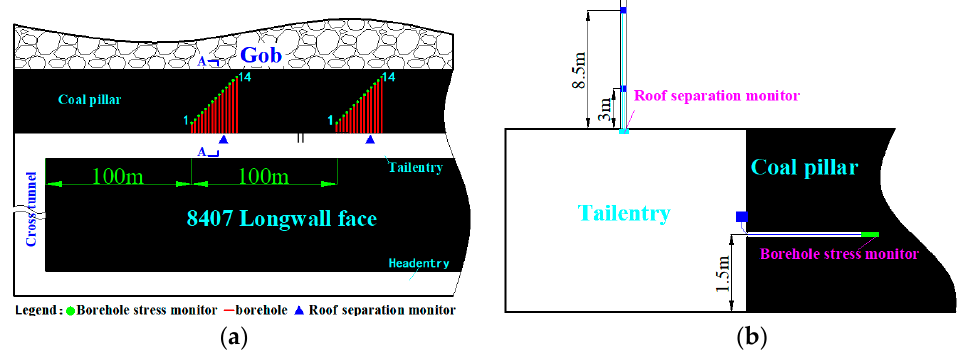
Figure 11. Layout of measuring station. ( a ) Layout plan of measuring station; ( b ) layout of measuring station A-A section.